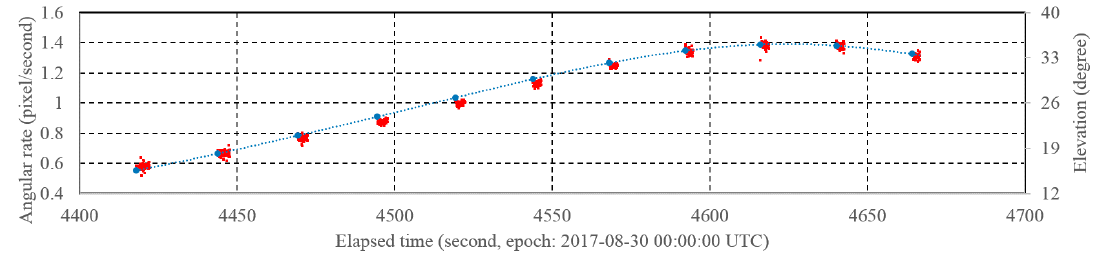
Figure 2. Angular rate (pixels/second) and pointing elevation (degree) for 11 shots in one observation set for CRYOSAT 2. The observation was performed at the OWL-Net in Israel. The angular rates in a single shot had similar values. The angular rates are proportional with the elevation angle of the satellite from the ground.